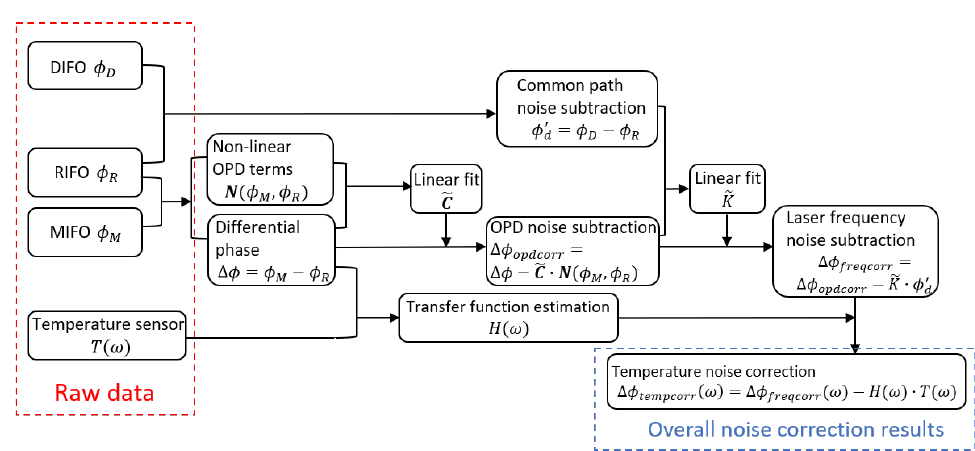
Figure 13. Flow chart of the overall noise correction algorithm. The non-linear OPD noise, laser frequency noise and the temperature fluctuation noise are characterized, and the contribution from each noise source is removed with this algorithm.